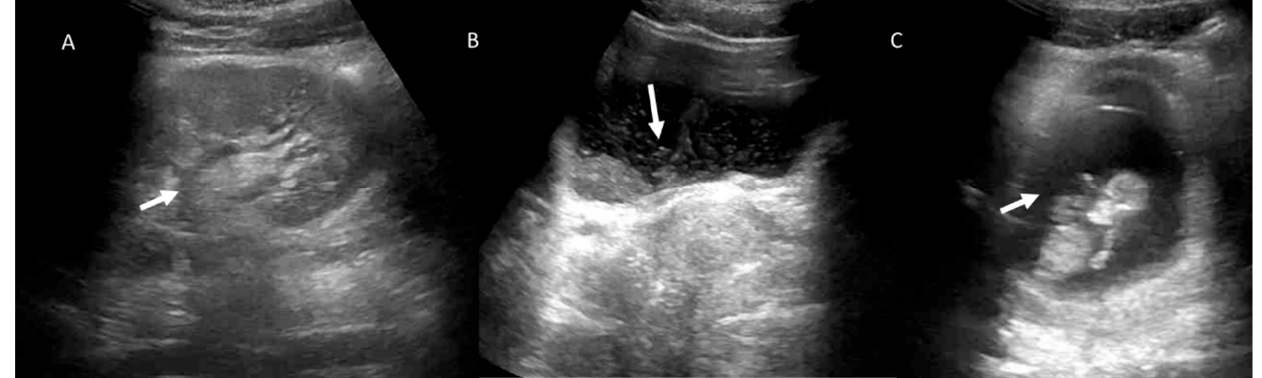
Figure 5. Pregnant woman ( C ) with abdominal pain and fever. US assessment shows hydroureteronephrosis with caliceal hyperechoic material (arrows) in ( A ) and thickening of the bladder walls, with intraluminal hyperechoic material in ( B ).